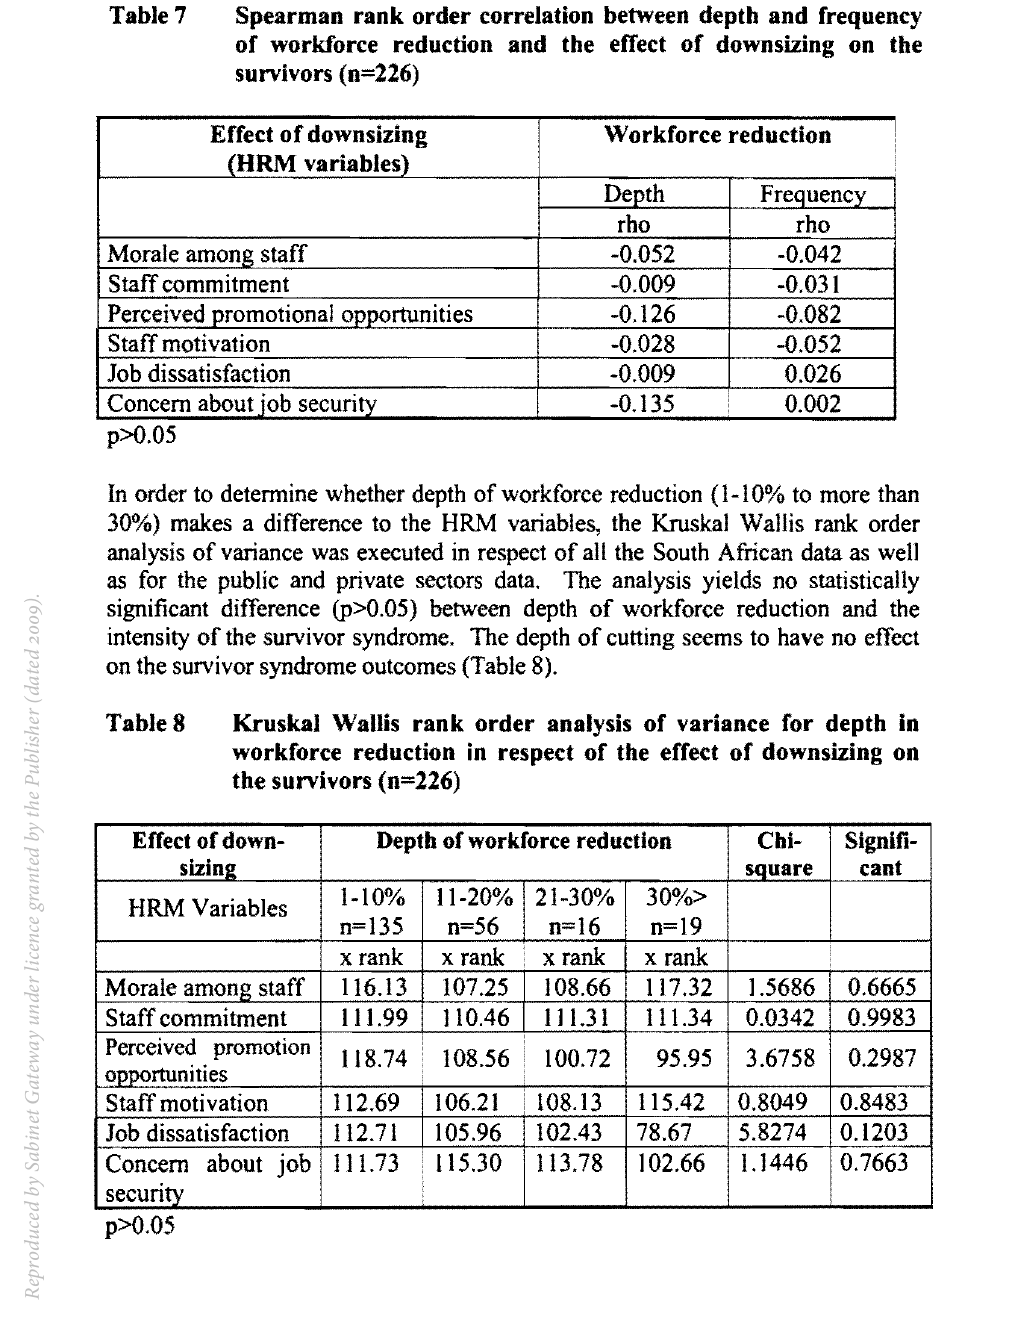
Spearman rank order correlation between depth and frequency of workforce reduction and the effect of downsizing on the